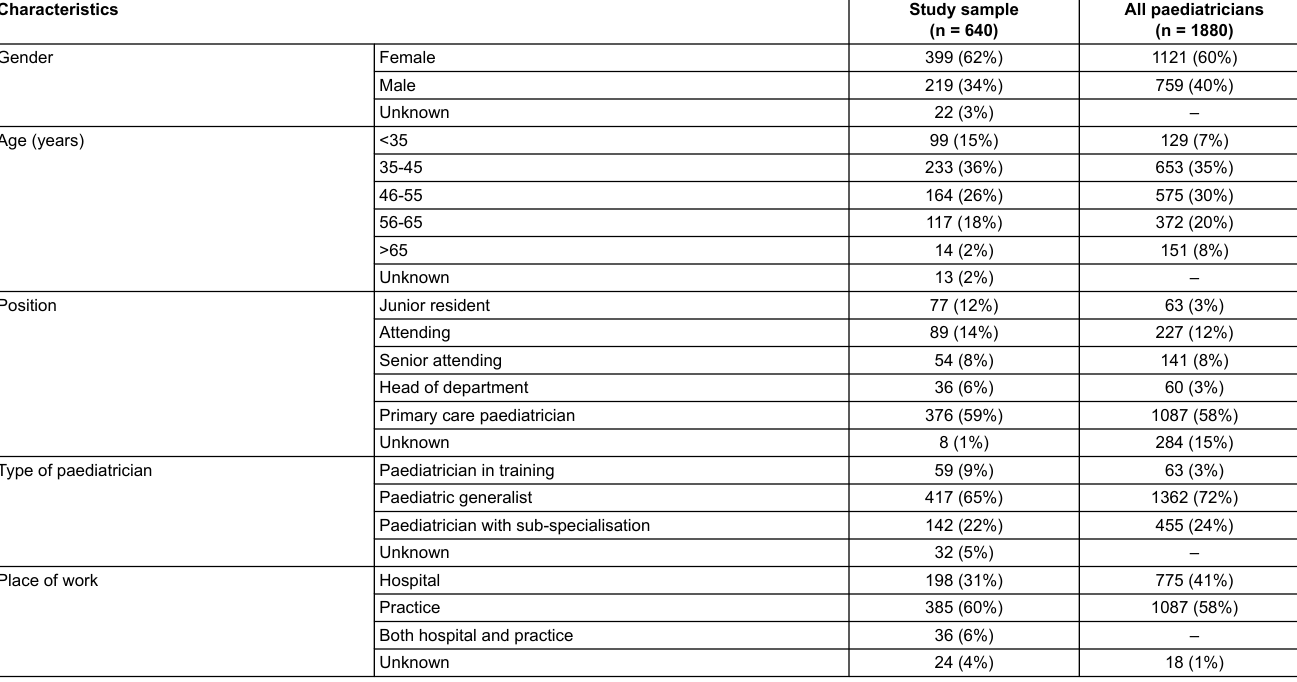
Table 1: Characteristics (percentage*) of paediatricians participating in the survey (“study sample”) and of all paediatricians registered with the Swiss Medical Association (FMH) at the end of 2016 (“all paediatricians”). Characteristics Study sample